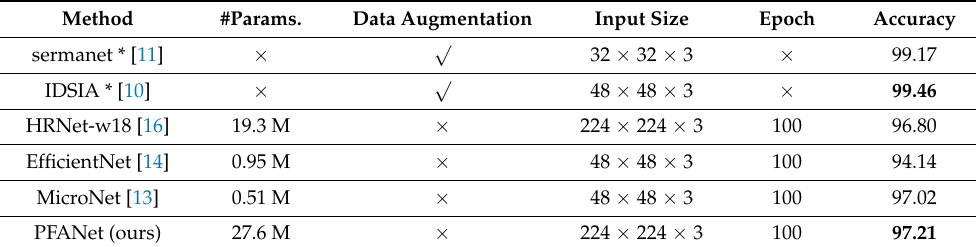
Table 4. The recognition results on German traffic sign recognition dataset (GTSRB) (public dataset). “*” represents result of the method is drawn from the literature, and without “*” represents the result is obtained from the re-trained